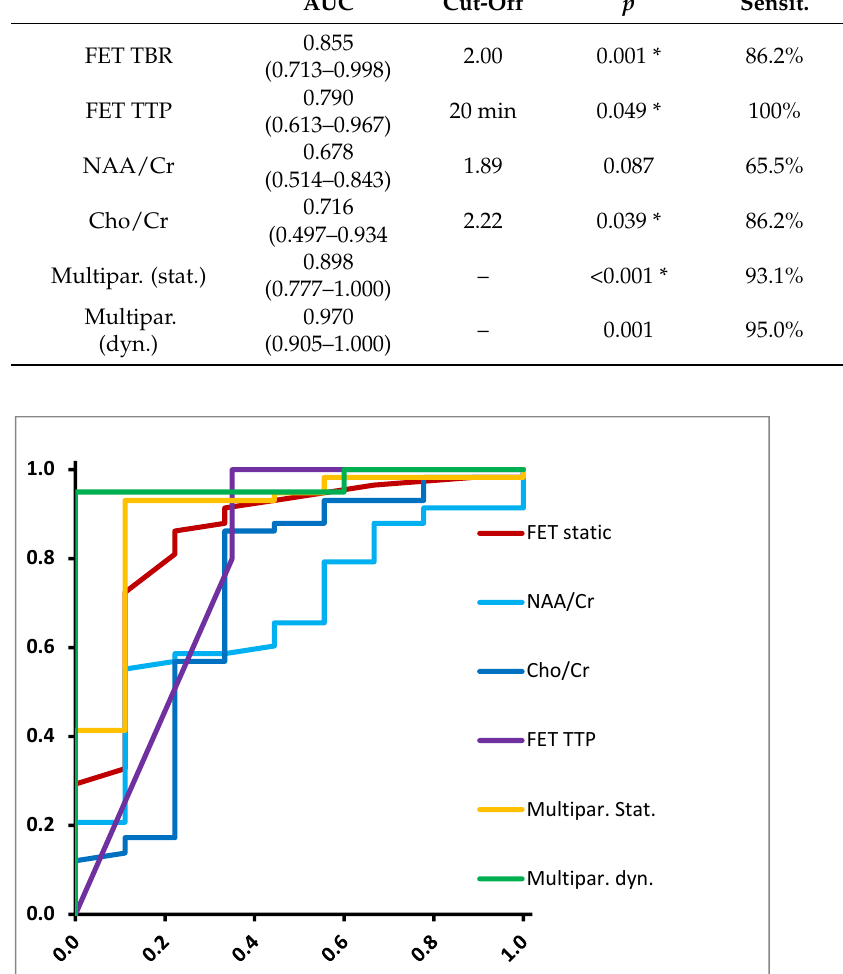
Figure 2. ROC curves for differentiation between low-grade and high-grade gliomas.